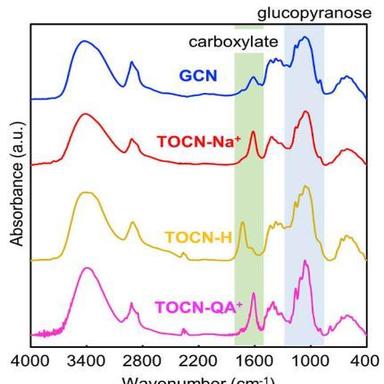
FT-IR spectra of cryogels of GCN, TOCN-Na+, TOCN-H and TOCN-QA+.